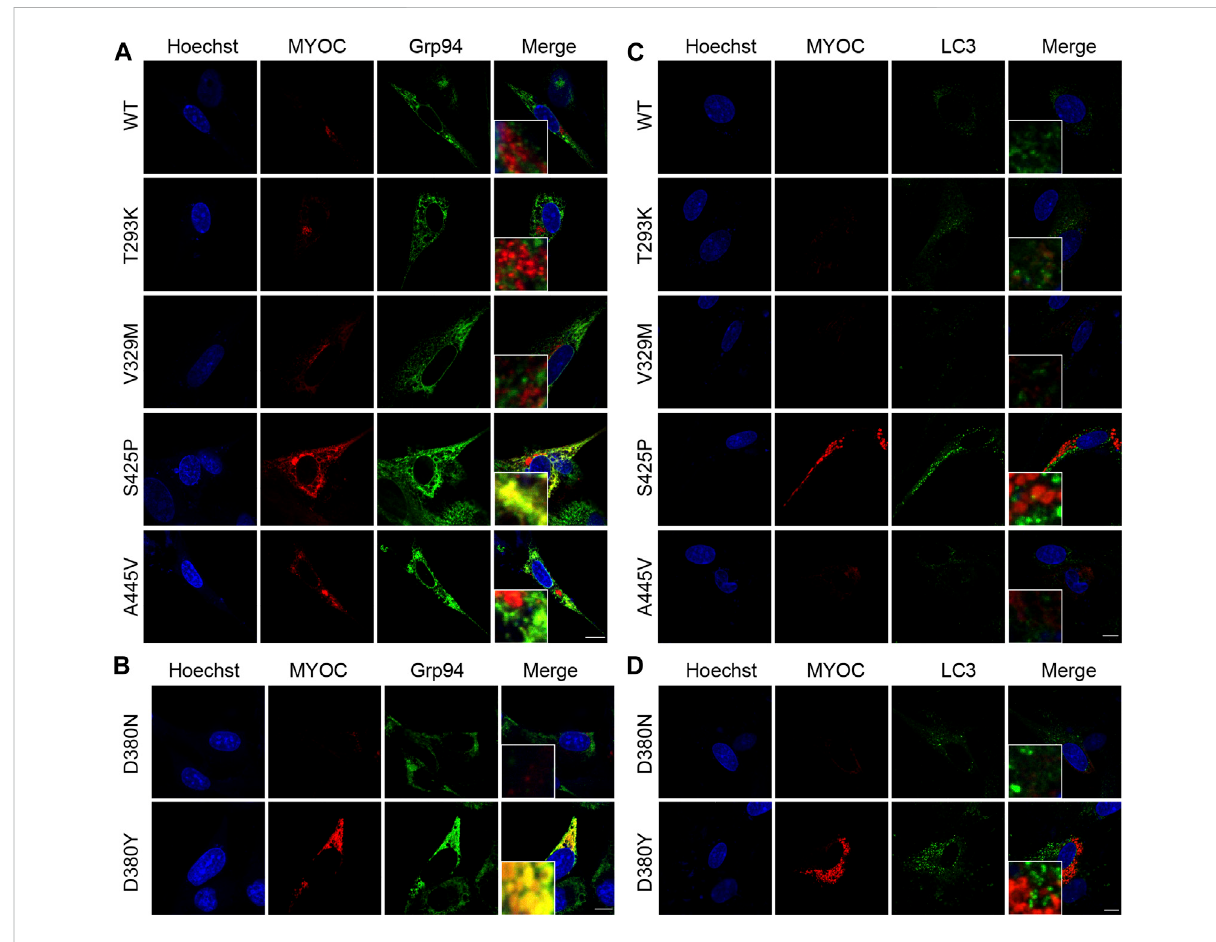
FIGURE 4 NonsecretedMYOC mutants induceER stress and impairautophagy. (A,B) Confocaldouble immuno fl uorescence for myocilin (red) and Grp94 (green) in iHTMCs transiently expressing WT or mutated MYOC. Nonsecreted mutations, including S425P and D380Y, show considerable colocalization of myocilin with Grp94. Scale bar: 25 μ m. (C,D) iHTMCs expressing WT or mutant myocilins were immunolabeled with LC3 (green) andMYOC(red).S425PandD380YmutantspresentincreasedintracellularmyocilinandLC3,withnocolocalizationofthesetwoproteins.Scale bar: 25 μ